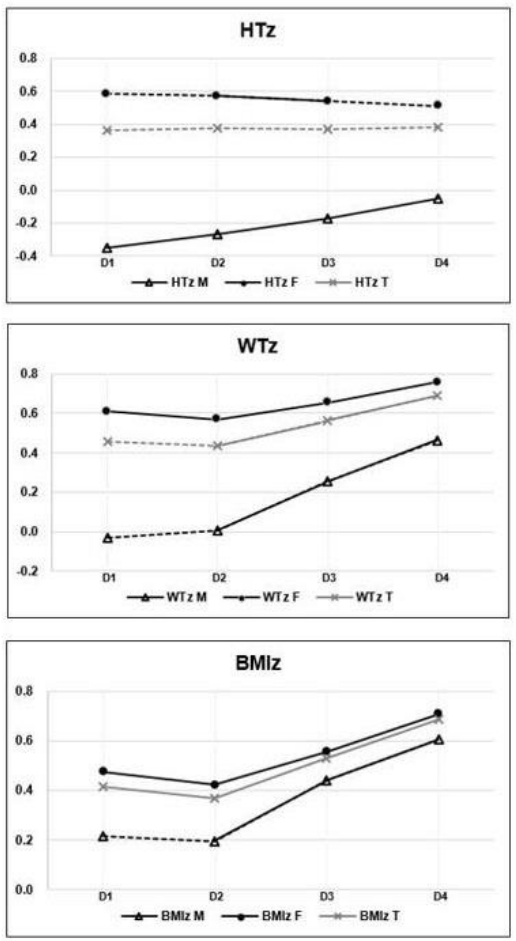
Figure 2. Z-scores of height (HT), weight (WT), and body mass index (BMI) at each visit date (D). D, date of visit; M, male; F, female; T, total; HTz, height z-score; WTz, weight z-score; BMIz, body mass index z-score. The solid line indicates that the difference in the value among the dates of visits is statistically significant, and the dotted line indicates non-significant differences. Table 2. The comparisons of z-scores among the visit dates (D).